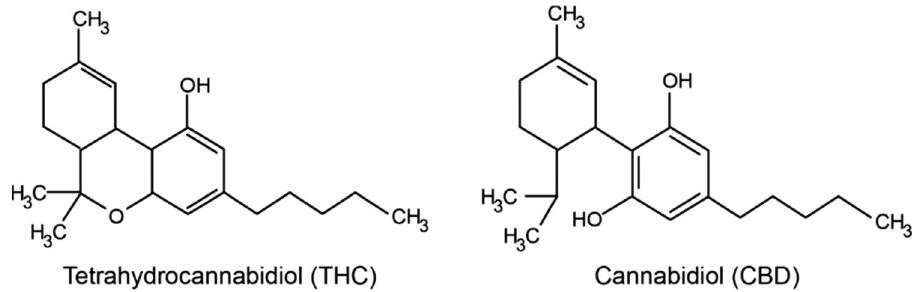
Figure 1. Chemical structures of THC and